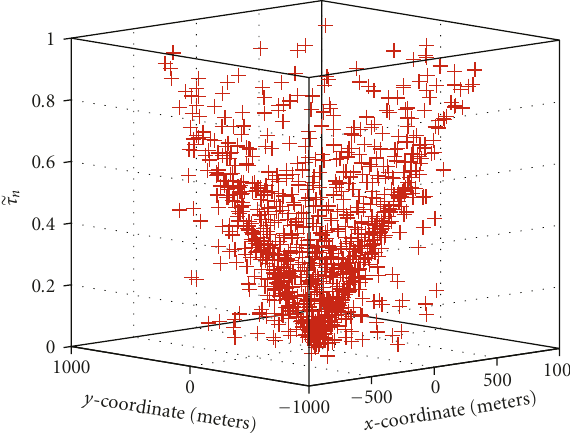
Figure 16: Spatial distribution of (cid:9) τ n in